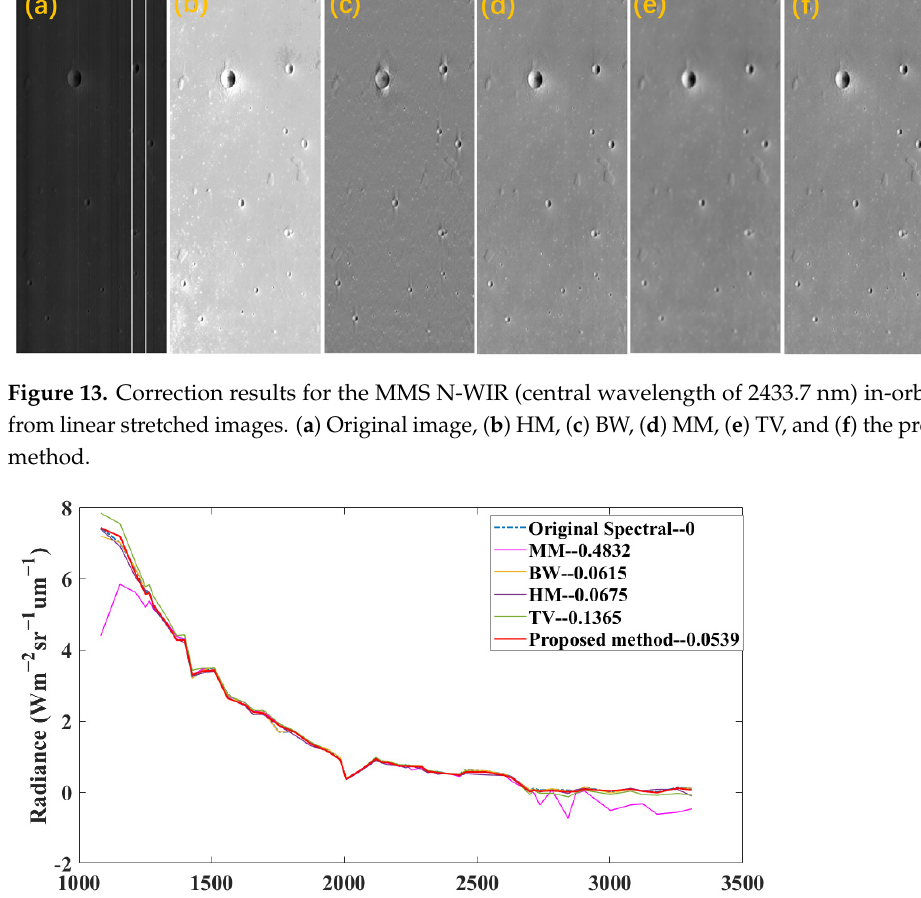
Figure 13. Correction results for the MMS N ‐ WIR (central wavelength of 2433.7 nm) in ‐ orbit data from linear stretched images. ( a ) Original image, ( b ) HM, ( c ) BW, ( d ) MM, ( e ) TV, and ( f ) the pro ‐ posed method.